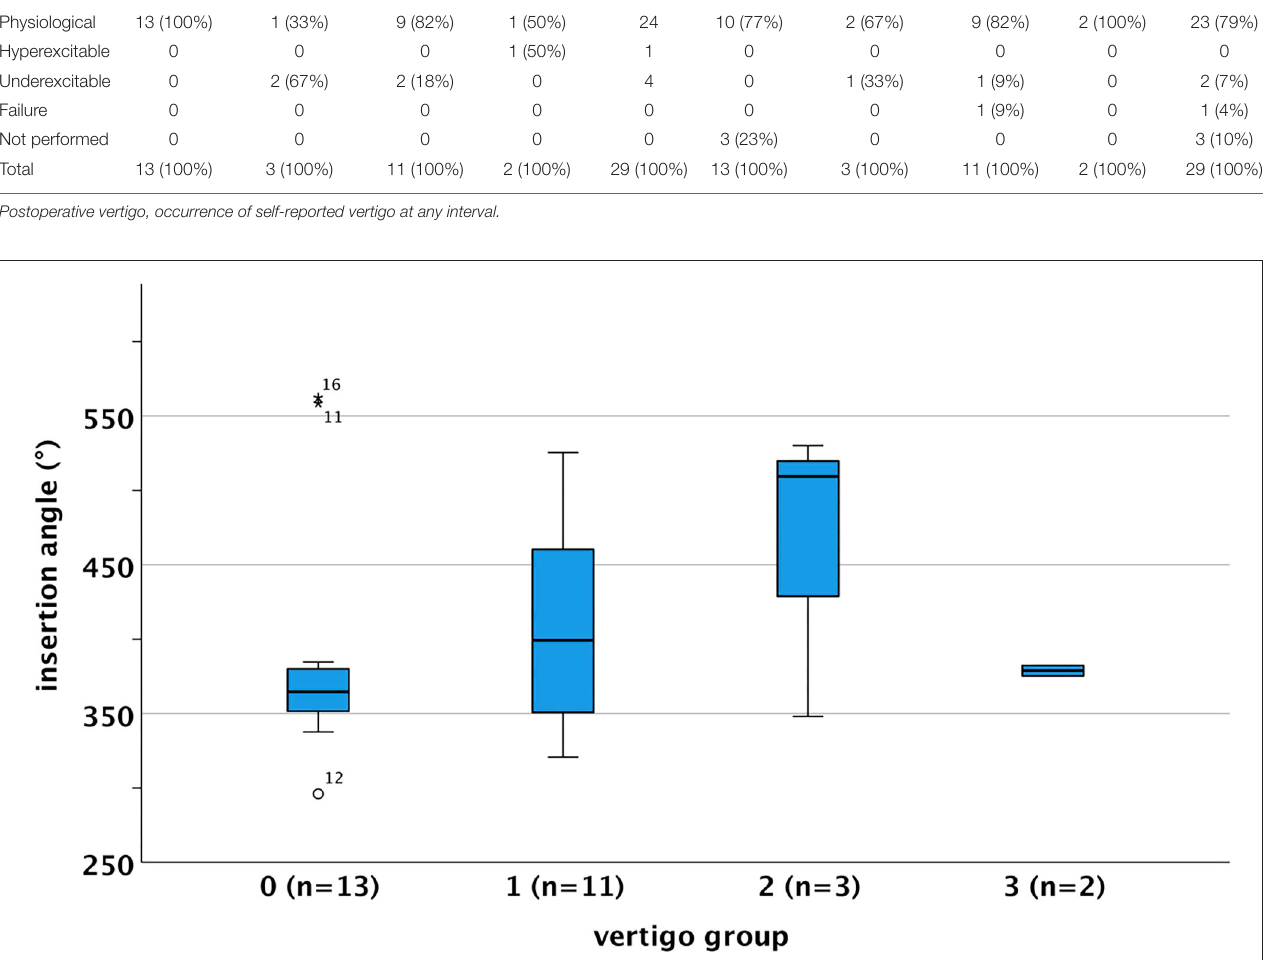
FIGURE 3 | Insertion angle (IA) distributions depending on vertigo group [boxplot, 0 = –/–, 1 = –/ + , 2 = + / + , 3 = + /–, vertigo ( + ) pre-op/postoperative]. The IA ranged in vertigo group 0 from 296.10 ◦ up to 562.24 ◦ (mean = 389 ± 82.90 ◦ ), in vertigo group 1 from 320.71 ◦ up to 525.5 ◦ (mean = 409.21 ± 72.29 ◦ ), in